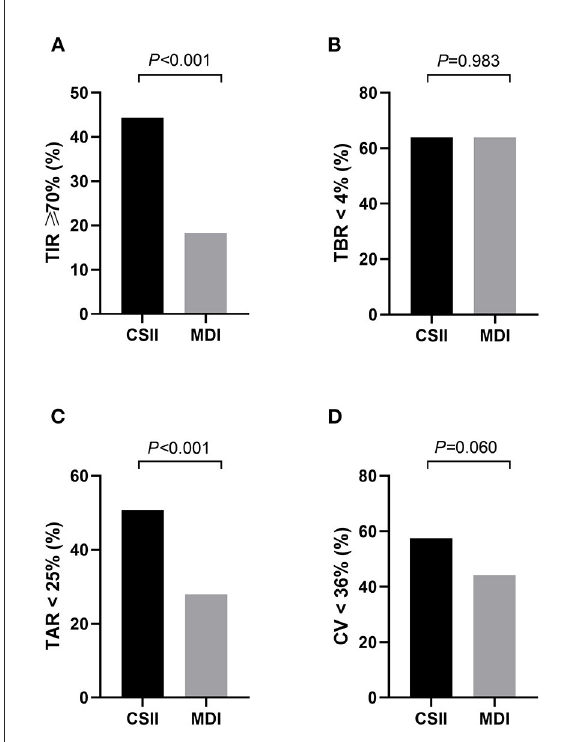
FIGURE2 The proportion of patients who achieved the CGM-associated targets in CSII group and MDI group ( n = 362). (A) TIR ≥ 70%, (B) TAR < 25%, (C) TBR < 4%, (D) CV < 36%. MDI, multiple daily insulin injection; CSII, continuous subcutaneous insulin infusion; TIR, time in range; TAR, time above range; TBR, time below range; CV, coefficient of variation. Data are shown as frequency. P -values for CSII group vs. MDI